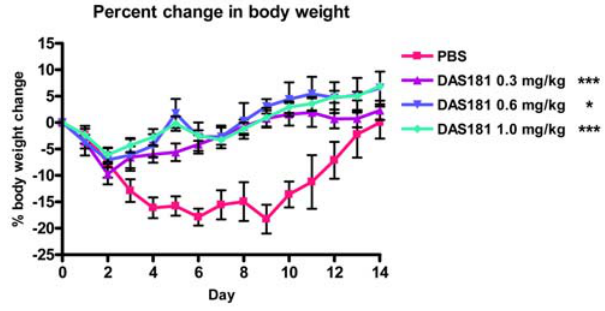
Figure 5. DAS181 inhibits pandemic IFV A(H1N1)-induced body weight loss in mice. BALB/c mice were inoculated with the pandemic influenza A(H1N1) virus A/Mexico/4108/2009 (1000 MID 50 / mouse, i.n. ). The mice were treated with PBS or DAS181 (0.3, 0.6, or 1 mg/kg) q.d.x5 , beginning 6 hours post-infection. Body weight was measured daily for 14 days p.i., and is expressed normalized to starting